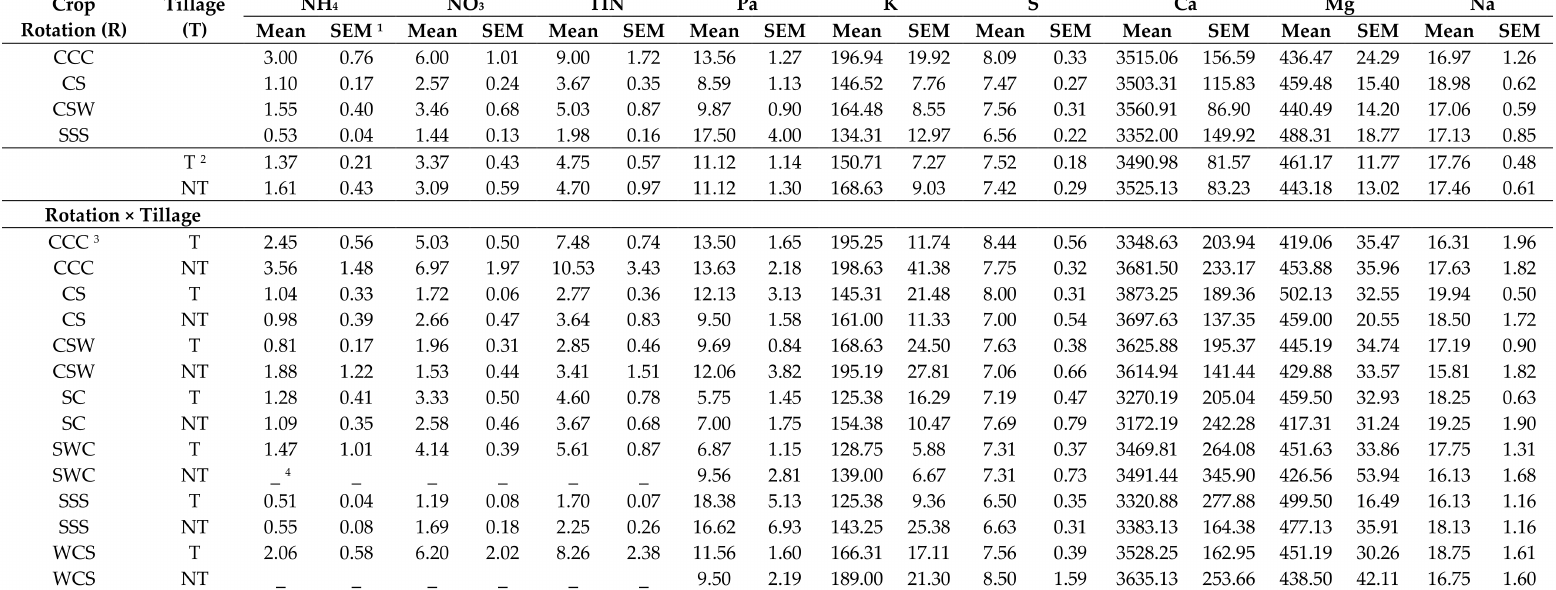
Table A7. Mean values of soil ammonia intensity (NH 4 , mg-N kg − 1 day − 1 during the growing season), soil nitrate intensity (NO 3 , mg-N kg − 1 day − 1 during